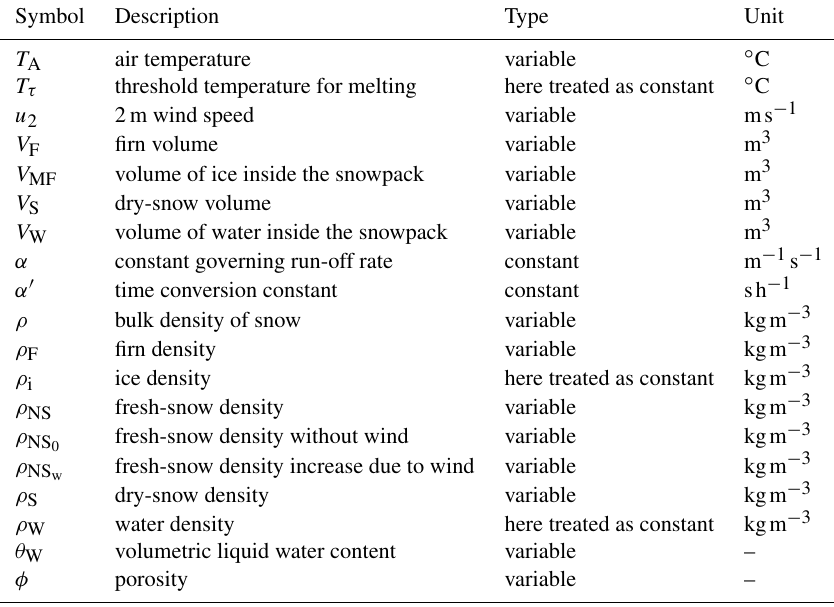
Table B2. List of the symbols used in the mass fluxes of the snow–firn model with the exclusion of snow erosion (from T to Z and Greek